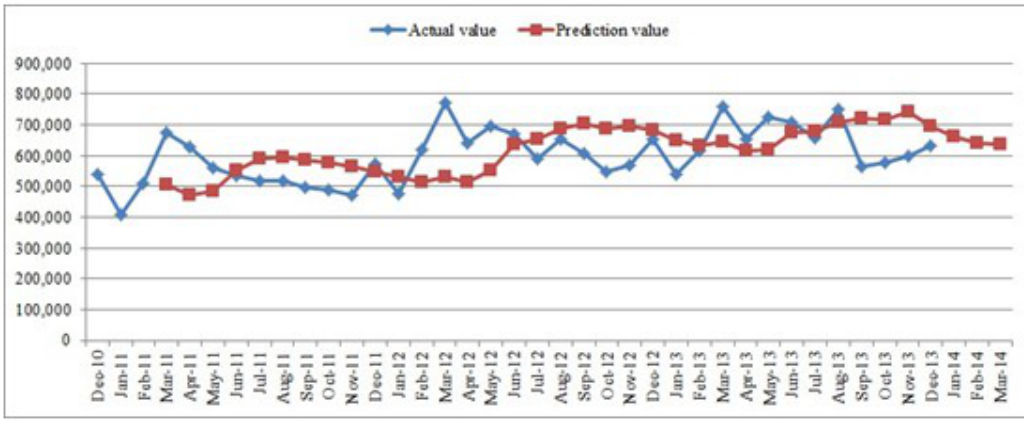
Figure 4. Prediction value of Car monthly sales from Dec. 2010 to Mar.